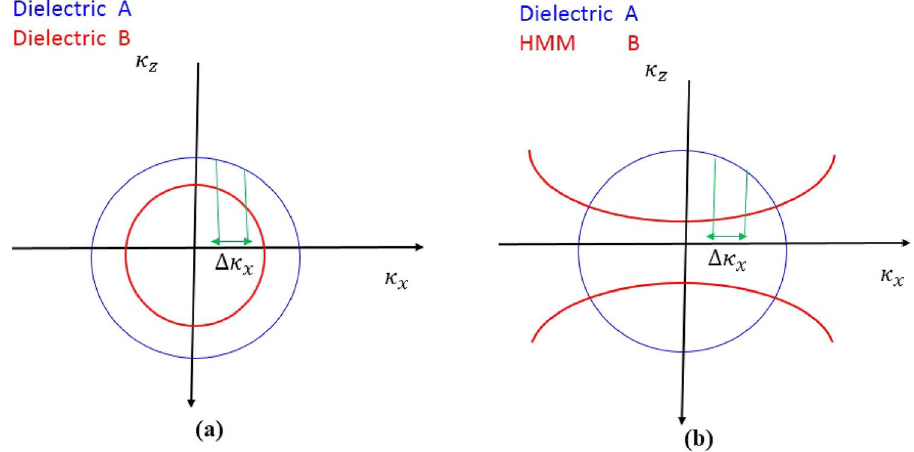
Figure 2. The schematic diagram of the iso-frequency curves of the dielectric and the HMM under TM